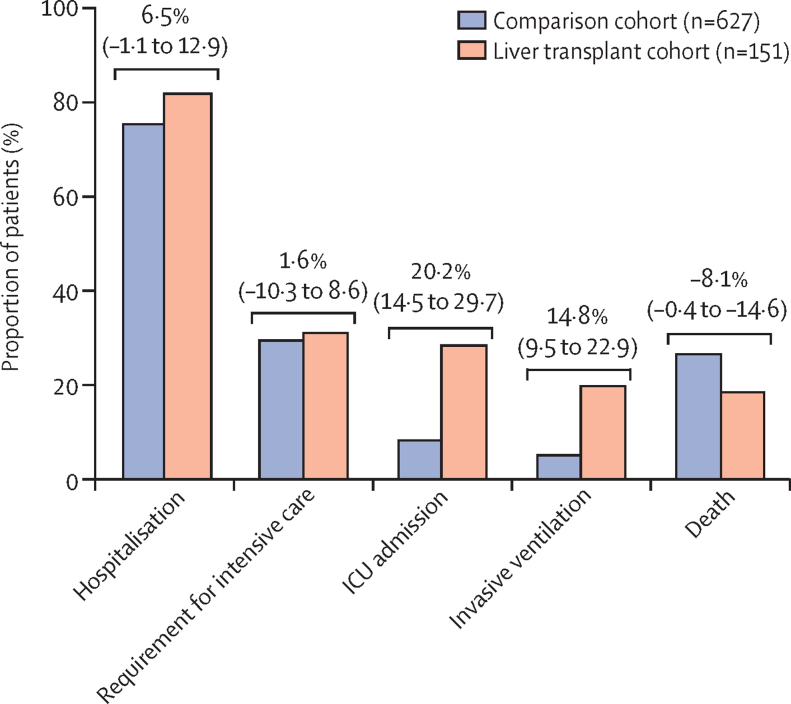
Major outcomes from severe acute respiratory syndrome coronavirus 2 infection in patients who have (n=151) and have not (n=627) undergone liver transplantationRisk differences between groups are presented with 95% CIs and were calculated with Newcombe's method 10. ICU=intensive care unit.